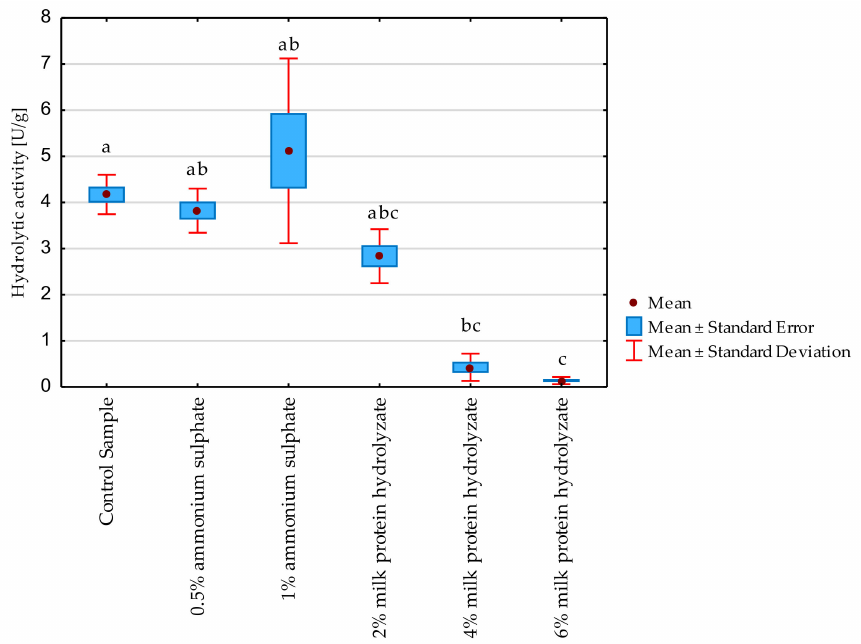
Figure 3. Effect of the used additive on the hydrolytic activity of freeze-dried preparations. Significant differences are marked with letters of the alphabet. Experiments were performed in